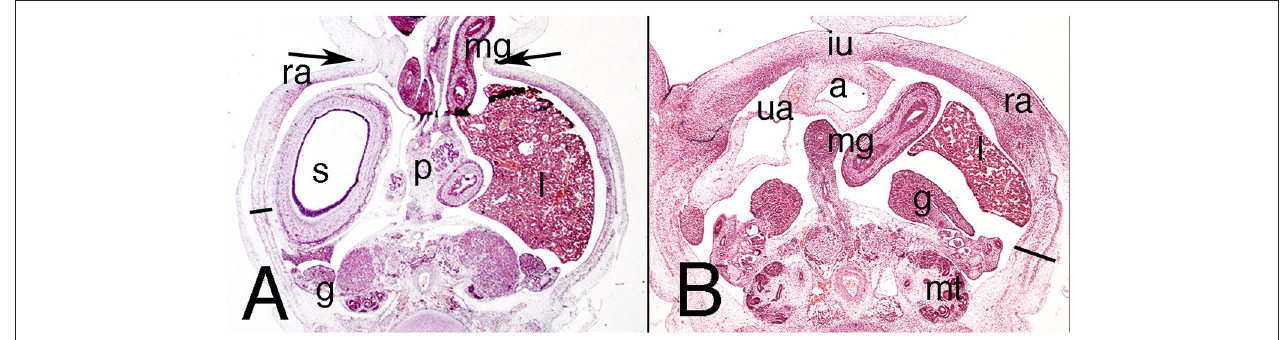
FIGURE 5 | Cross section of embryo ES-20 (stage 20) at the abdominal region. Hematoxylin and eosin staining. (A) (1X) lower level of the umbilical hernia and (B) (2X) section at the infra-umbilical region. a, allantois; iu, infra-umbilical region; g, gonad; l, liver; m, mesonephros; mg, middle gut; mt, metanephros; p, pancreas; ra, rectus abdominis; s, stomach; ua, umbilical artery. Arrows, neck of the umbilical hernia; bar, differentiated lateral abdominal muscles.